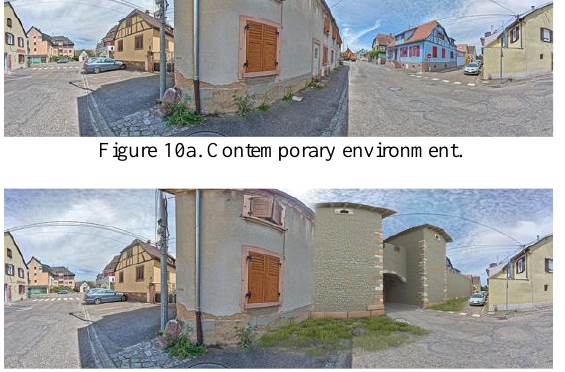
Figure 10b. Castellum in contemporary environment.